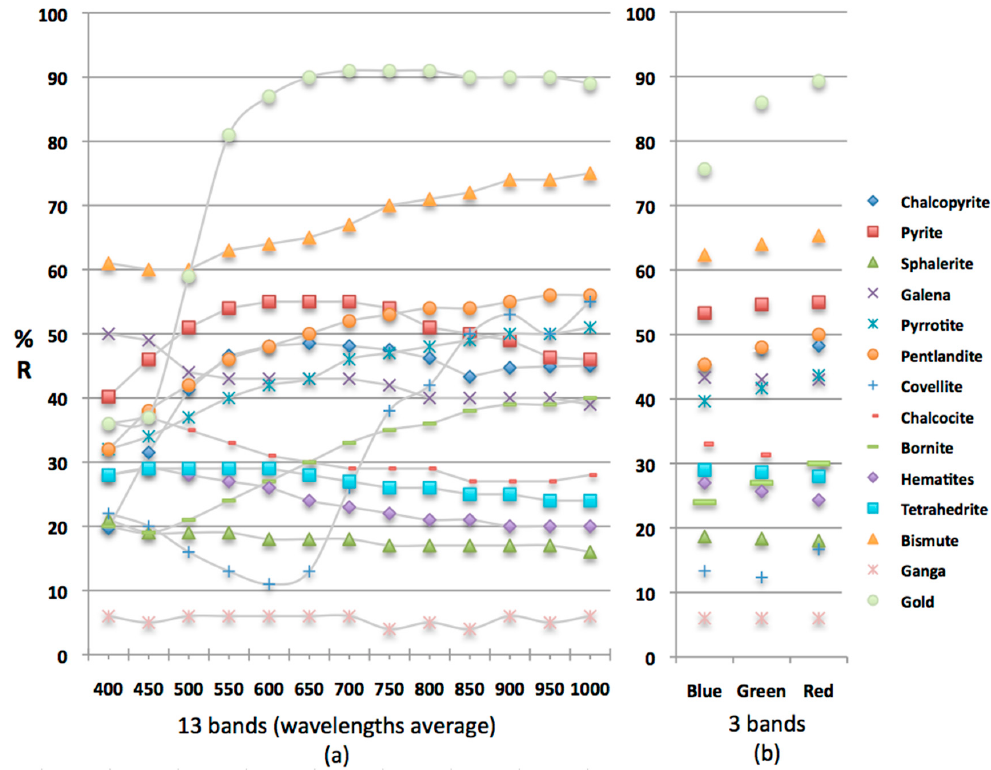
Figure 11. ( a ) Reflectance intensity response (average) of 14 ore minerals studied for 13 wavelengths bands (CAMEVA System). ( b ) Reflectance intensity response (average) of 14 ore minerals for Blue, Green and Red. Based on Quantitative Data File III [31]. Table 5. Examples of specific multispectral characteristics (multispectral and color) that are unique to each mineral studied (averages in percent and ratios).